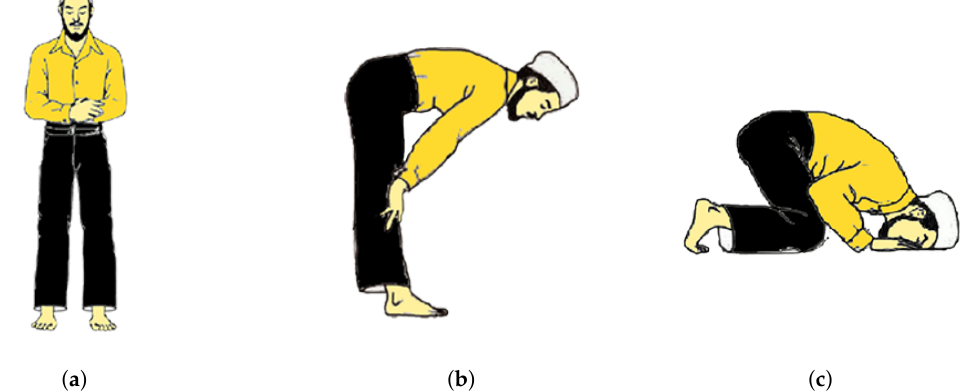
Figure 1. Three main activities in each Rakat : ( a ) Al-Qayam (Standing); ( b ) Ruku (Standing to Bowing); ( c ) Sujud (Standing to